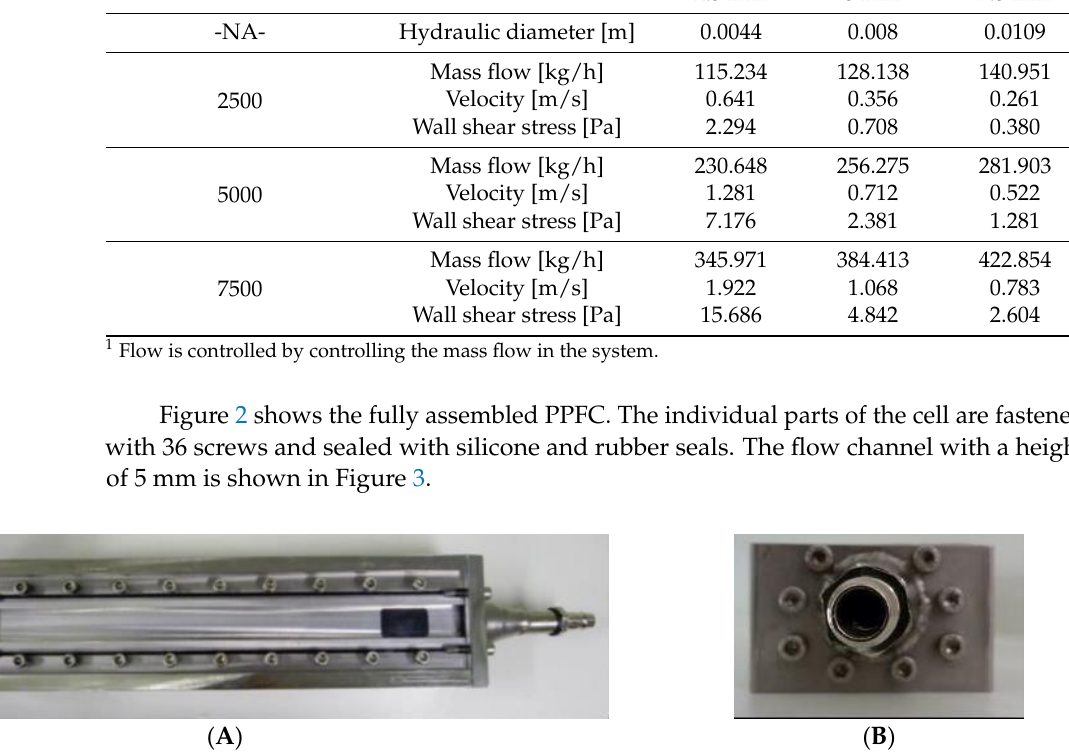
Figure 2. The fully assembled PPFC: ( A ) top view of the flow measurement cell and ( B ) side view of the flow measurement cell.